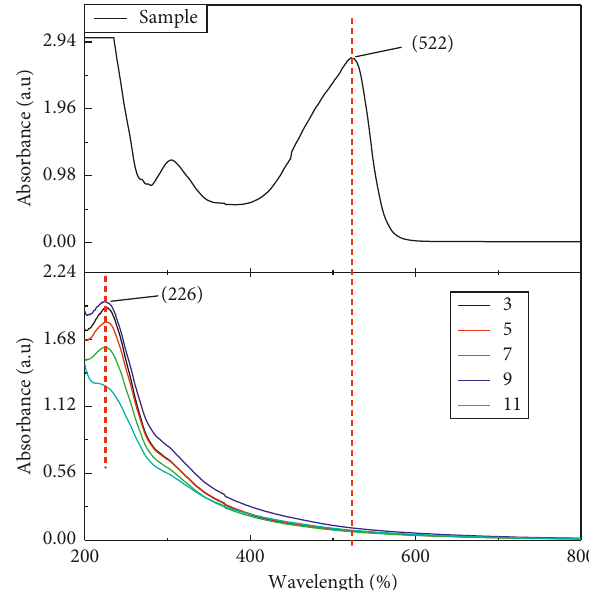
Figure 8: UV–Vis of GO after fluoride ion adsorption and the inset is the UV–Vis of the